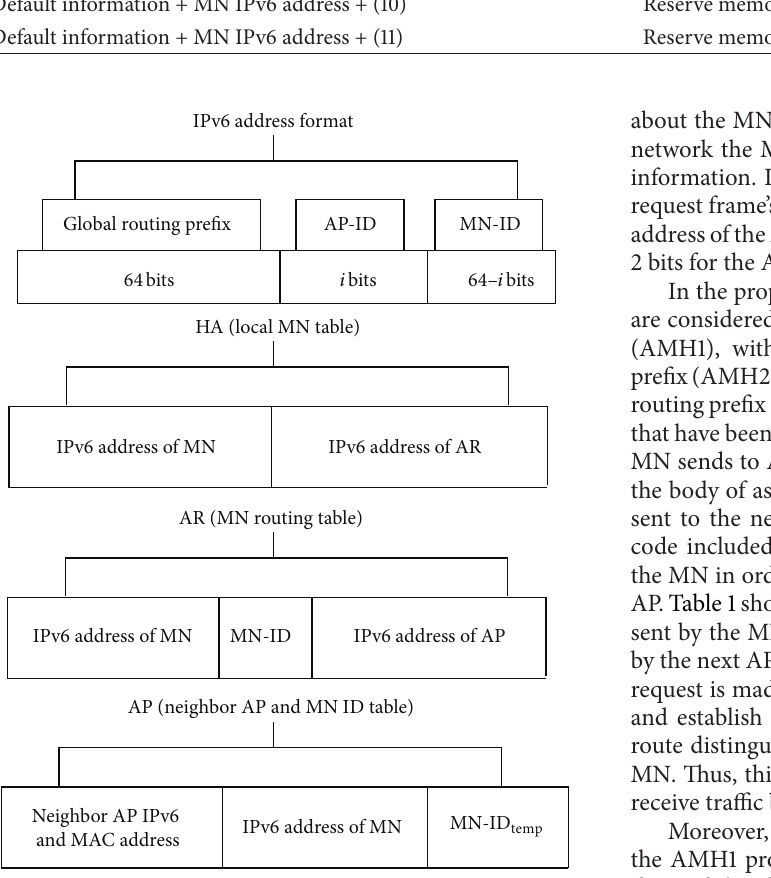
Figure 2: The format of the proposed unique IPv6 address and data structure as a table form saving in each of HA, AR, and AP in the proposed AMH